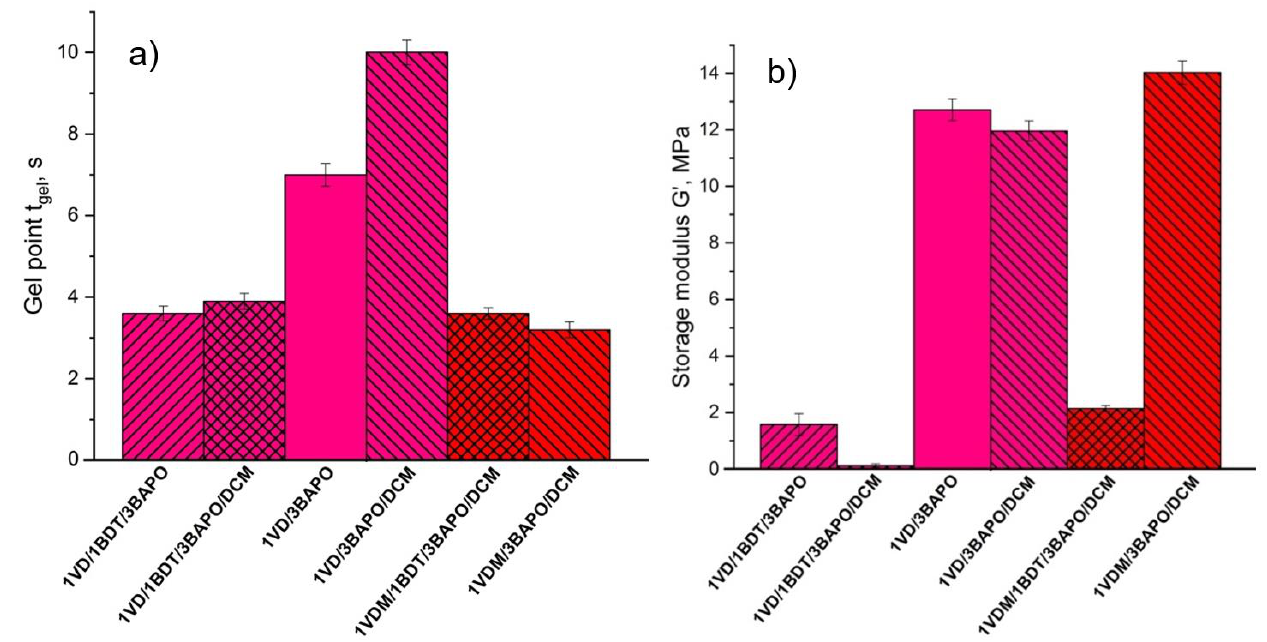
Figure 6. Gel point t gel ( a ) and storage modulus G ’ ( b ) of the VD and VDM-based resins with 3 mol% of BAPO. Pink columns—VD-based resin; red columns—VDM-based resin; leaning lines from bottom to top—presence of 1.3 BDT; leaning lines from top to bottom—presence of DCM.